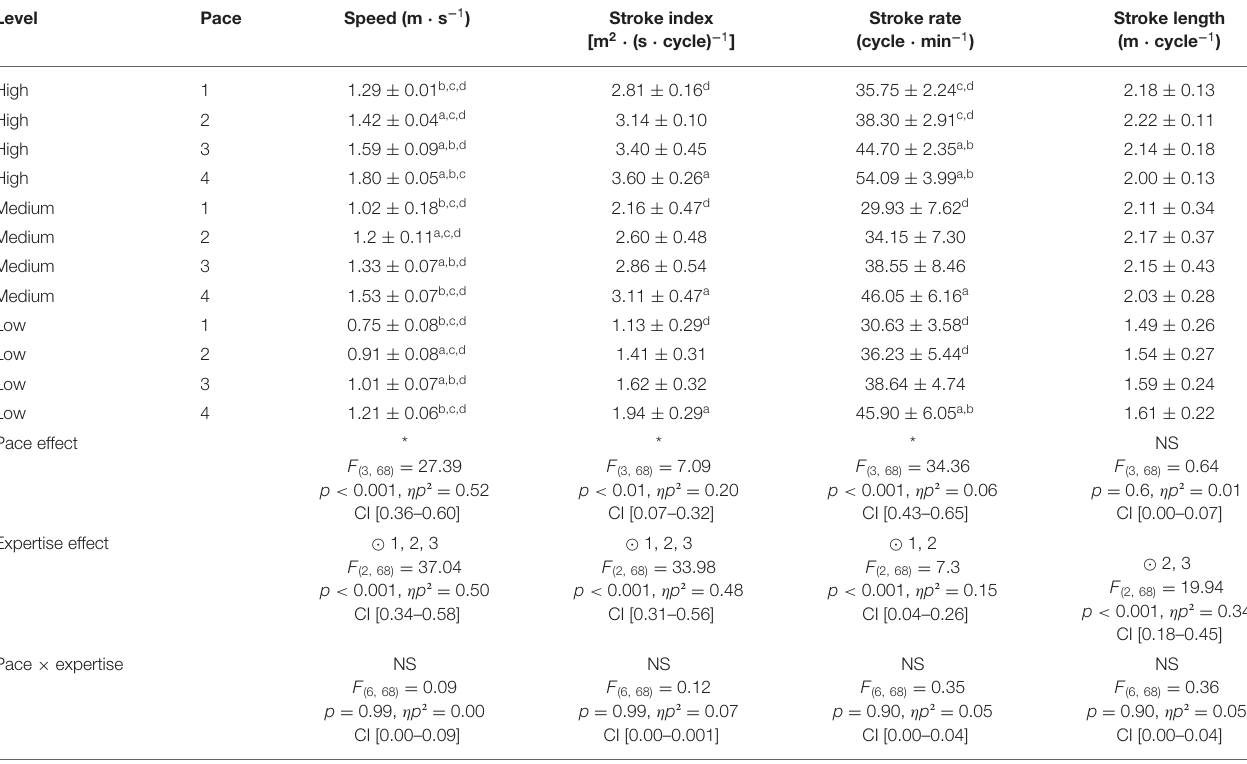
TABLE 3 | Stroking parameters according to pace and expertise